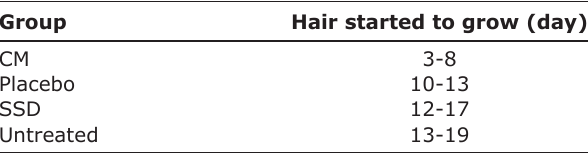
Table-4: Days hair started to grow.